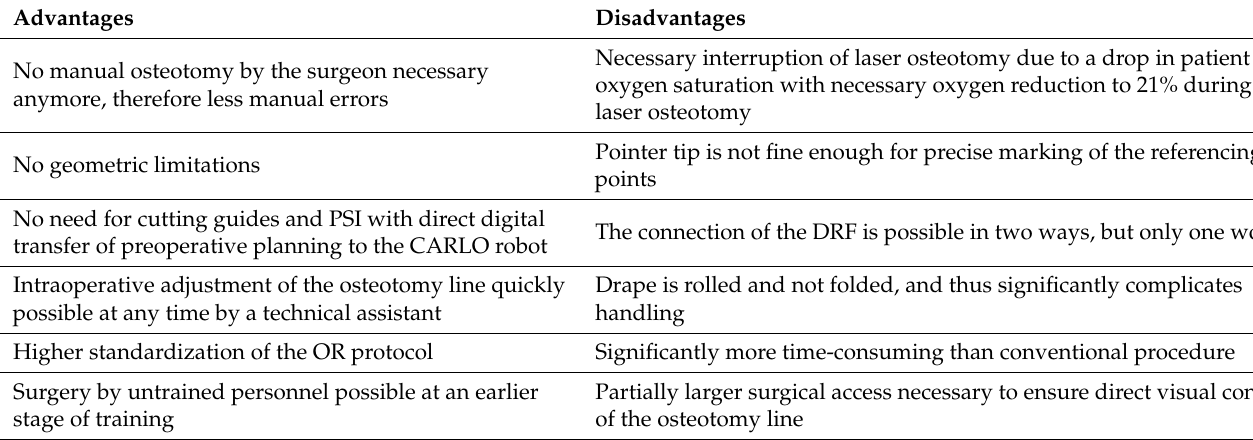
Table 2. Advantages and disadvantages of using CARLO ® device.